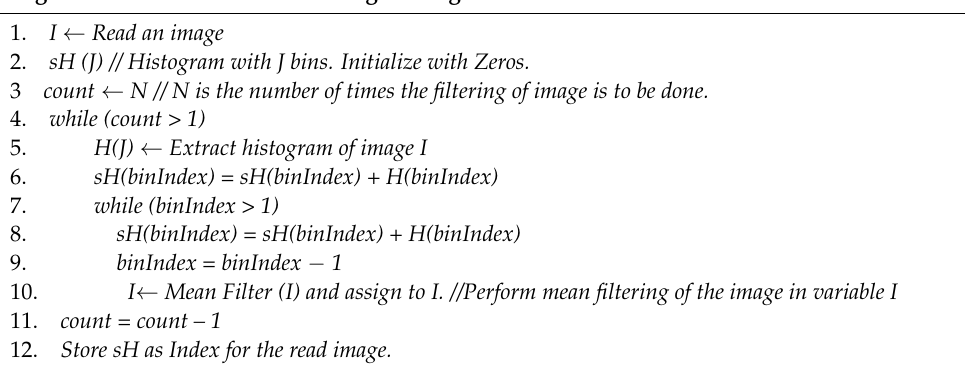
Algorithm 1. Stacked Colour Histogram